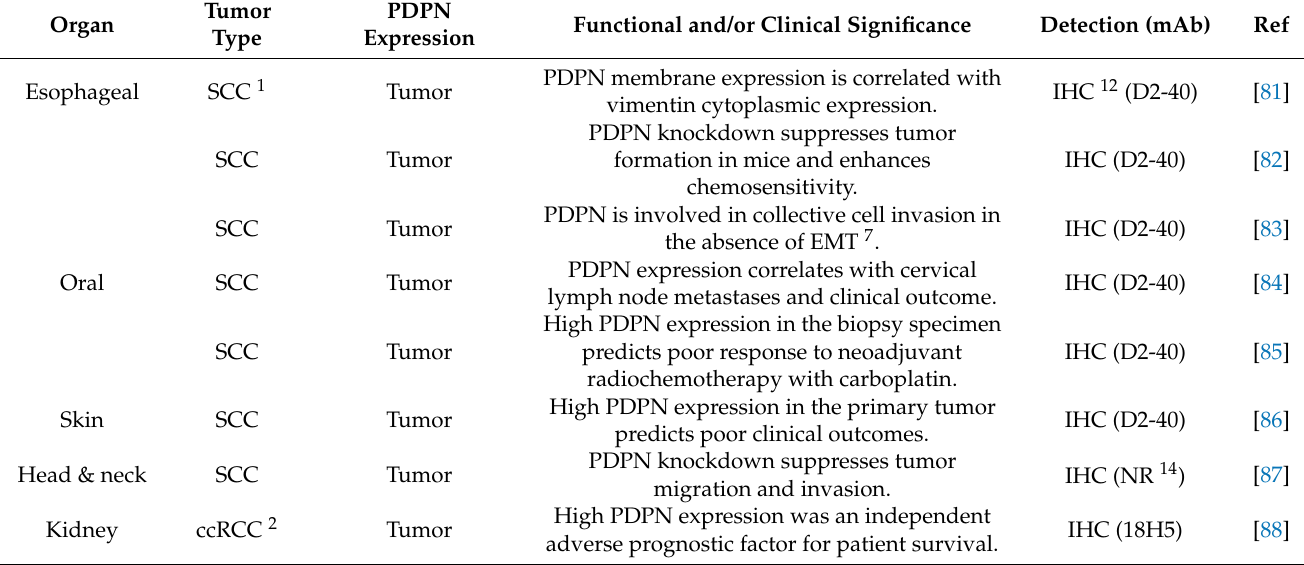
Table 1. Association of PDPN expression with poor clinical